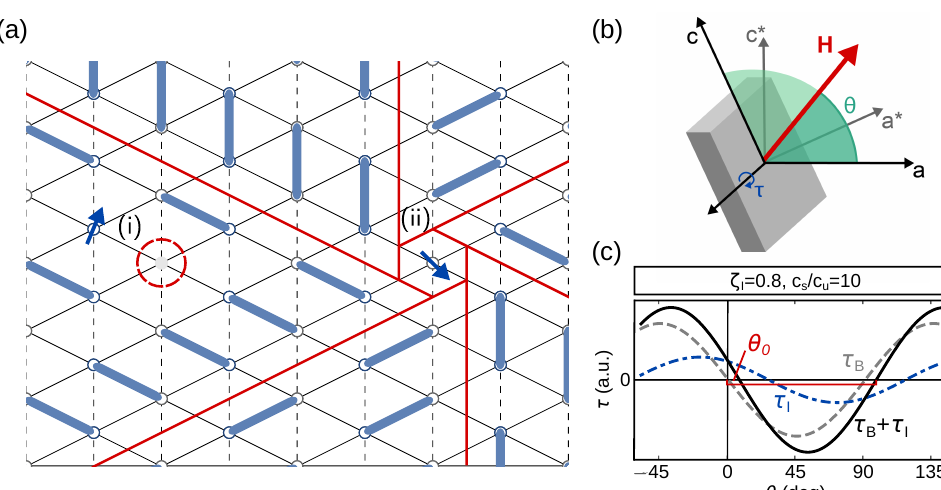
Figure 10. ( a ) Disorder scenarios in a valence-bond solid state, discussed for κ -(BEDT-TTF) 2 Cu 2 (CN) 3 . Local spin 1/2, or so-called “orphan spins”, may be caused by (i) vacancies in the anion layer, emphasized by the red circle or (ii) specific domain wall patterns, a possible result of randomness in the ethylene endgroup conformation. ( b ) Magnetic-torque setup, with crystal axes a and c (with a ∗ ⊥ bc , c ∗ ⊥ ab ), magnetic field H and the angle θ between sample and field. ( c ) Theoretical magnetic torque τ dependence on field angle θ , with indication of the angle shift θ 0 and resolution of impurity ( τ I ) and bulk ( τ B ) contributions. Figures adapted from Ref.